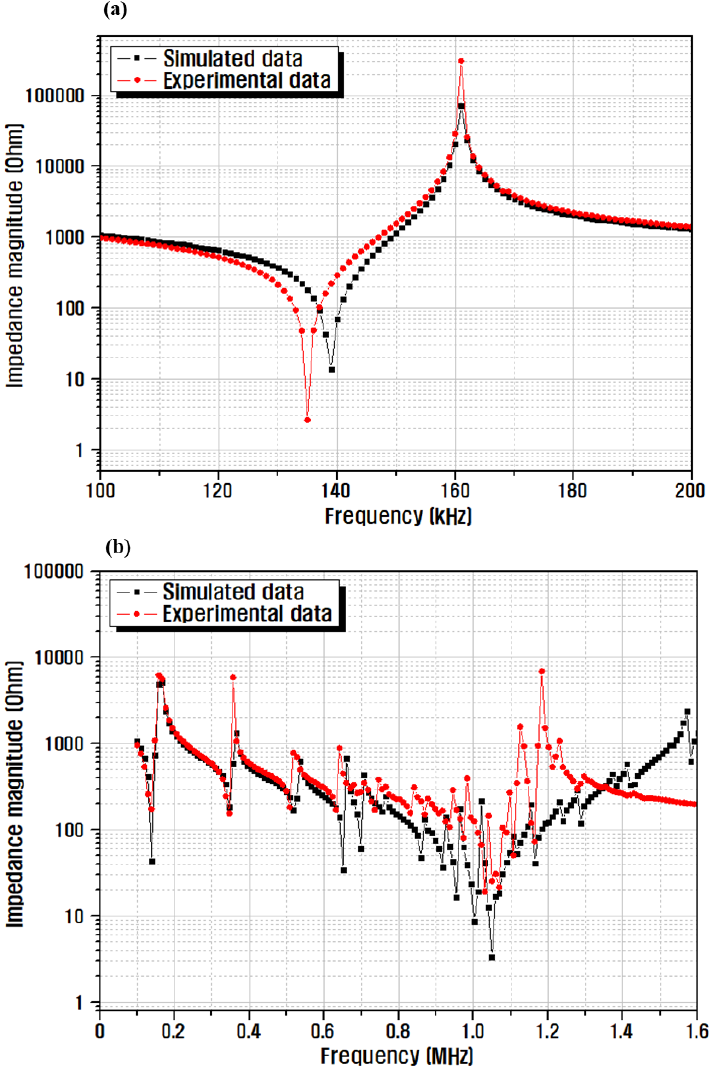
Figure 7. Simulation and impedance analysis results, according to the frequency of the fabricated sample: ( a ) radial, and ( b ) thickness vibration